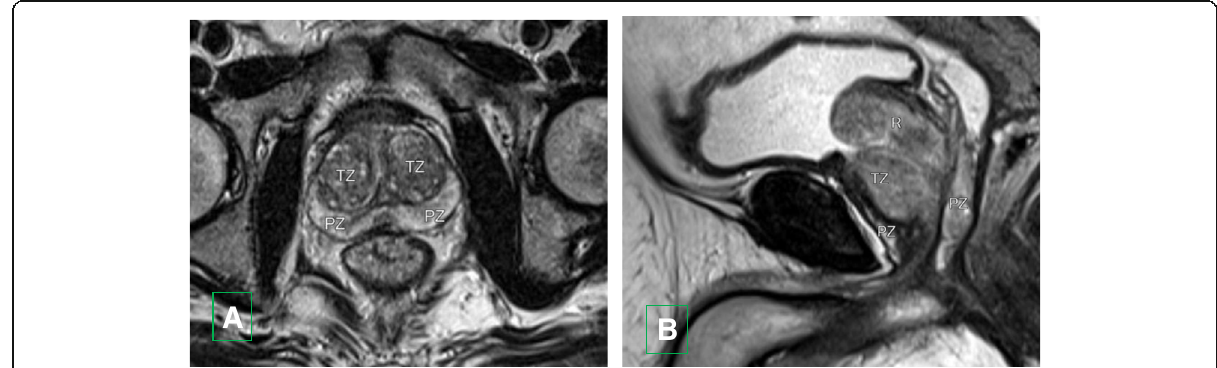
Fig. 5 Sixty-nine years old man with type 3 BPH. a Axial T2 WI showing bilateral transition zone (TZ) (lateral lobe) enlargement. Peripheral zone (PZ) is noted. b Sagittal T2 WI showing transition zone (TZ) and retrourethral (median) lobe enlargement (R). Peripheral zone (PZ) is noted